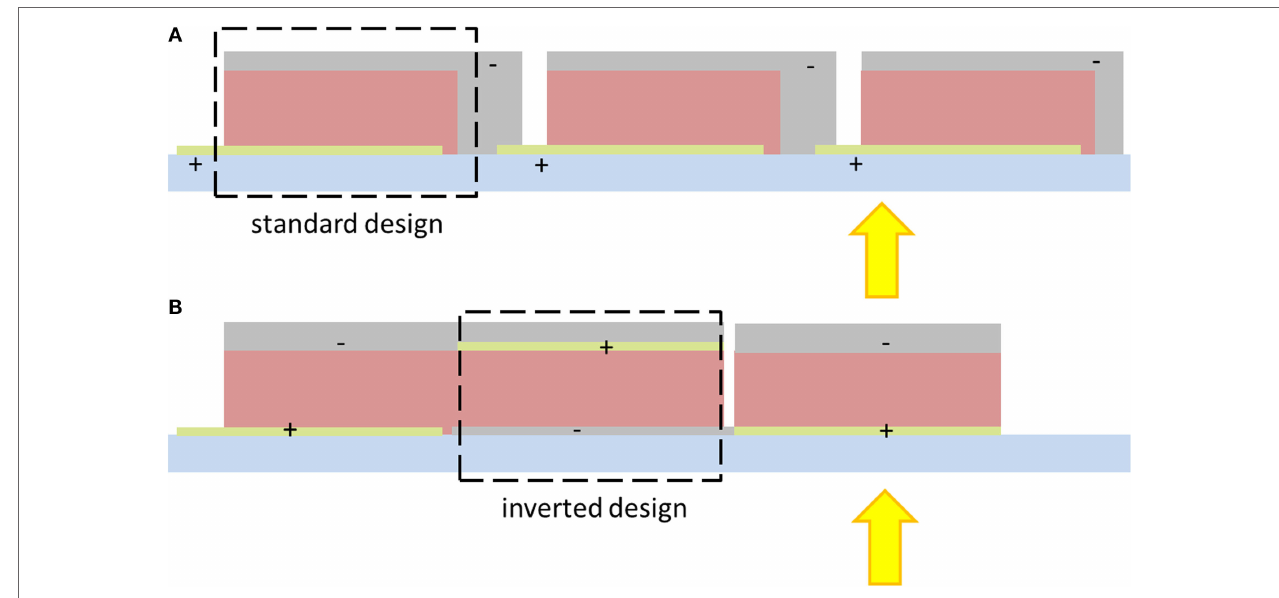
FigUre 1 | (a) Monolithic module interconnection and (B) alternative module